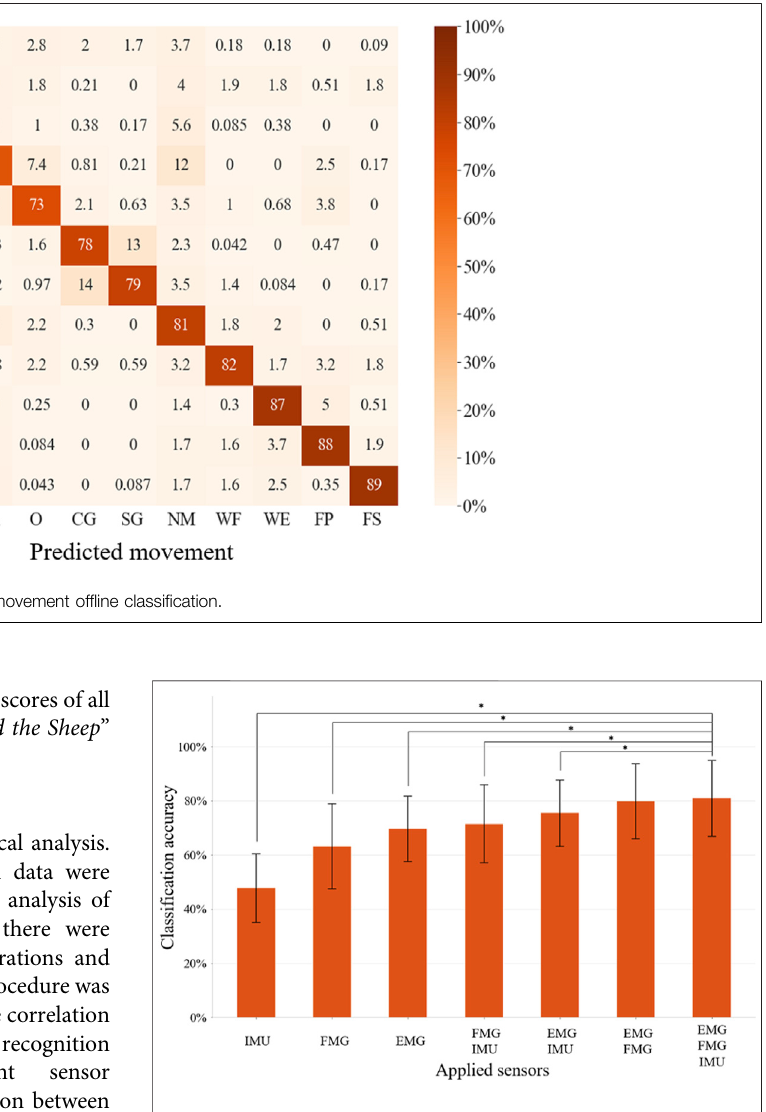
FIGURE 6 | The classi fi cation accuracy of 12 movements using different combinations of sensors. Bars represents one SD. * represents statistical signi fi cance ( p < 0.05). The application of three sensors signi fi cantly improves the recognition accuracy compared to the application of IMU, FMG, EMG, FMG+IMU, or EMG+IMU,